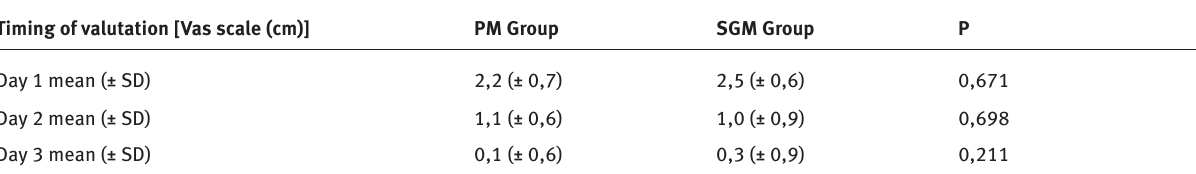
Table 4b: VAS Scale evaluation in elderly